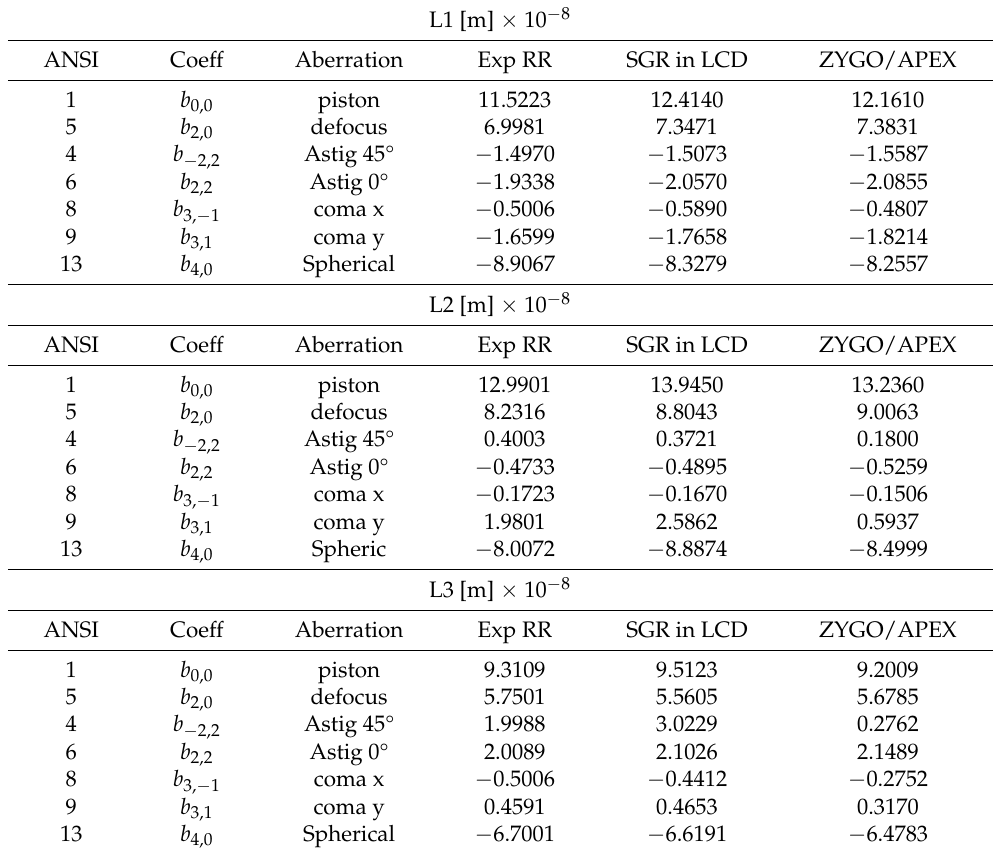
Table 1. We show the main aberration coefficients (following the ANSI ordering protocols) corre- sponding to L1, L2, and L3, obtained experimentally, applying the TIE with the RR, simulating the SGR in the LCD and the data obtained by